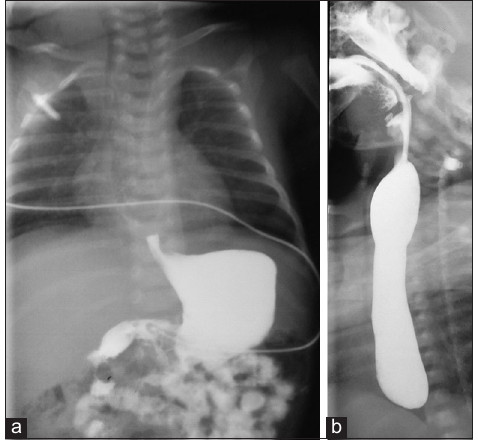
a Figure 2: (a) Esophagogram showing a congenital web near the esogastric junction. (b) The proximal esophagus is dilated.